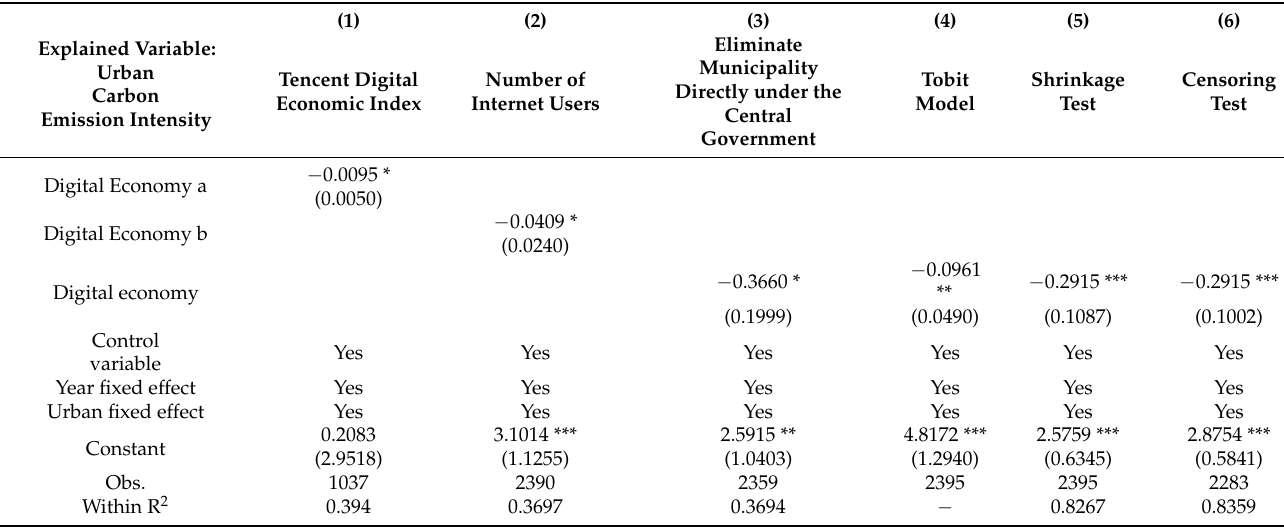
Table 3. Results of robustness